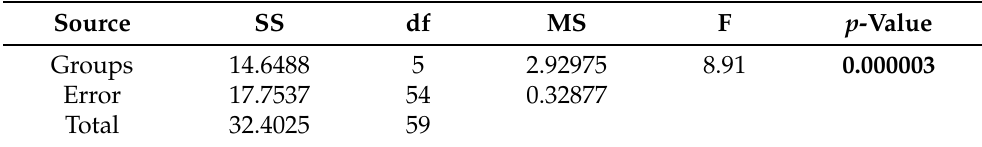
Table 14. ANOVA table results on dataset